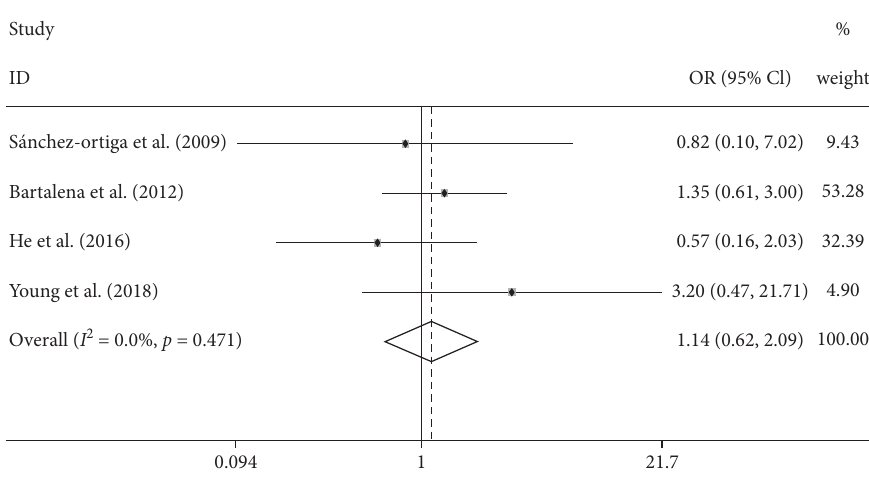
Figure 4: Forest plot of the incidence of adverse events, EUGOGO regimen vs. higher-dose